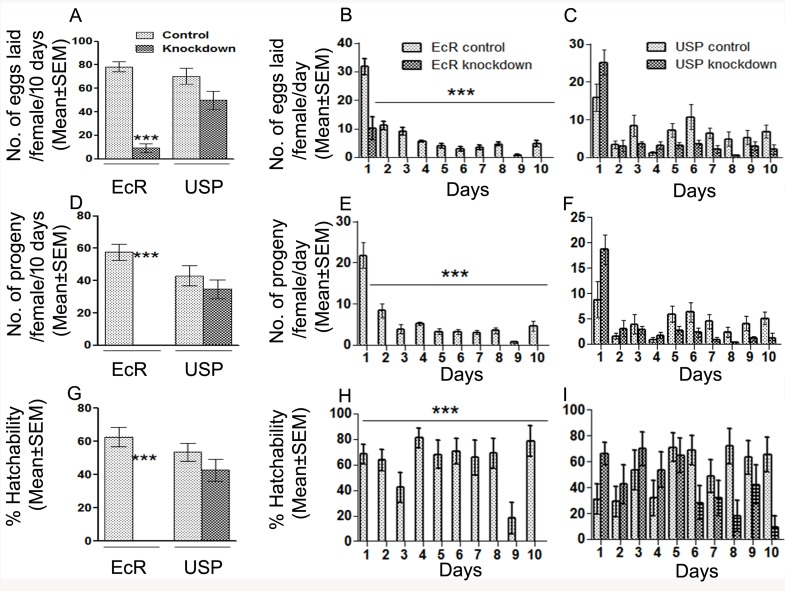
Reproductive performance of females mated to EcR or USP knockdown males over period of 10 days.Panel A represents the overall fecundity (total no. of eggs laid/10 days) of mated females while Panels B and C represent day wise fecundity (no. of egg laid/day from day1-10) of mated females. The overall fecundity of EcR knockdown mates was significantly lower compared to controls (***p<0.0001). However, overall fecundity of USP knockdown mates was comparable to their controls. (p = 0.08). Further, EcR knockdown mates laid eggs for 24hr ASM, albeit at significantly fewer numbers (***p<0.0001) when compared to control and did not lay eggs from days 2–10. USP knockdown mates did not deviate from controls on day wise egg laying. Interestingly, there were no progeny from the eggs laid by EcR knockdown mates over period of 10 days (overall fertility, ***p<0.0001, Panel D; day-wise fertility, ***p<0.0001 Panel E). USP knockdown or control mates had comparable overall (Panel D; p = 0.3, USP) as well as day wise fertility (Panel F; p = 0.06 lowest) EcR control and knockdown mates differ significantly on total % hatchability (Panel G; EcR, ***p<0.0001) as well as % hatchability on day 1 (Panel H; ***p<0.0001). USP control and knockdown mates had significant differences in % hatchability on days 8 and 10 (Panel I; p = 0.01) but that did not have a significant bearing on the overall % hatchability (Panel H; p = 0.3). Values given here are Mean±SEM involving at least 15–30 females depending on the hormone receptor.